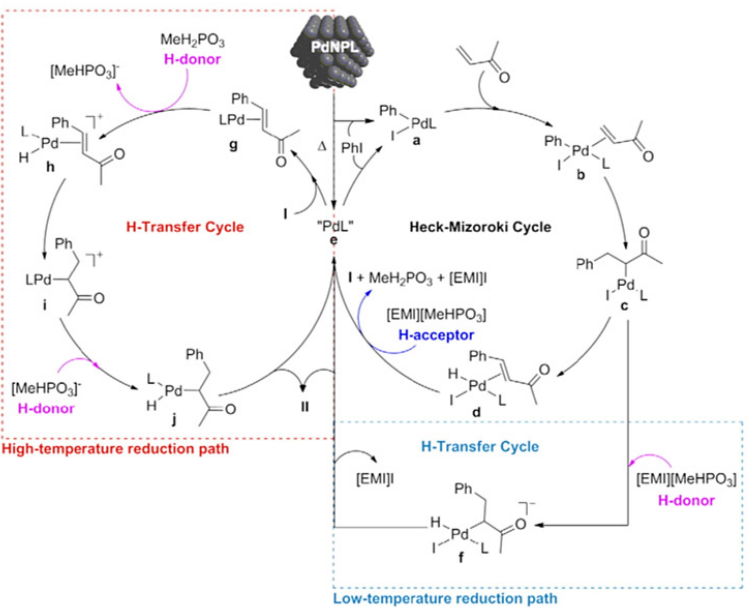
Figure 9. Proposed mechanism for the one-pot sequential Heck/hydrogenation reaction promoted by pre-formed PdNPs in [EMI][MeHPO 3 ] ( I stands for 4-phenyl-3-buten-2-one and II stands for 4-phenyl-2-butanone). Reproduced from [119] with permission from Elsevier.